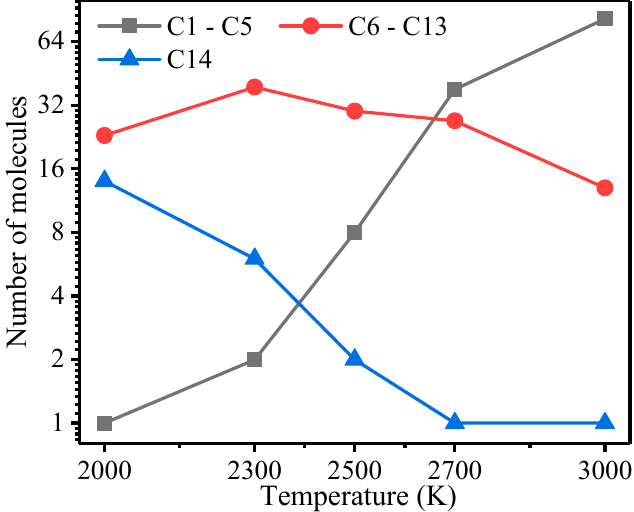
Figure 6. Product of meta-aramid fiber pyrolysis after 100 ps at different temperatures.